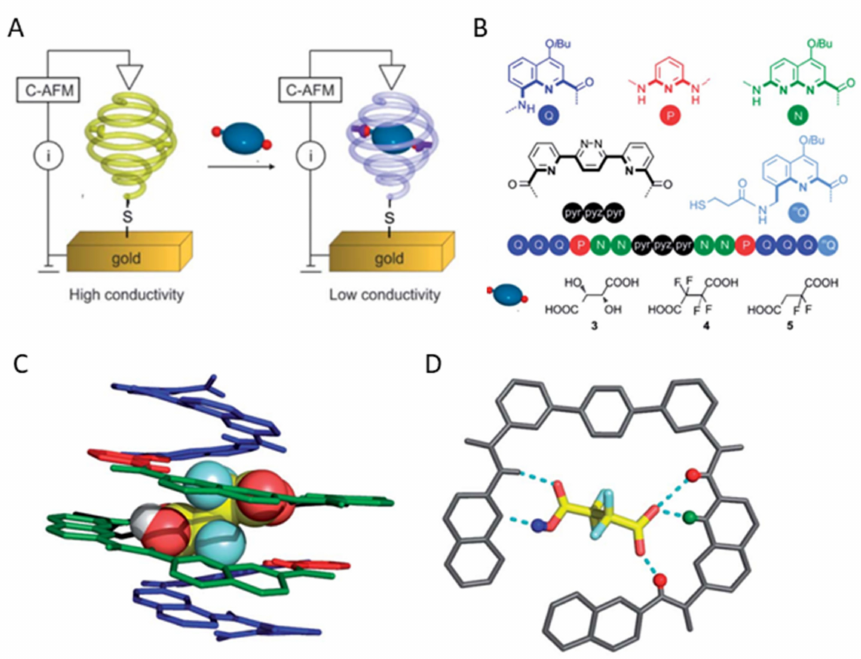
Figure 15. ( A ) Foldamer grafted to a gold surface constitute a probe for detection of diacids. Con- ductive AFM assesses the effect on conductivity upon protonation of the foldamer backbone via the recognition of an acidic guest. ( B ) Chemical structures of foldamer building blocks. ( C ) The guest is shown in foldamer-filling representation. ( D ) Top view of the central part of the complex. Reprinted with permission from reference [220]. Copyright 2021 the Royal Society of